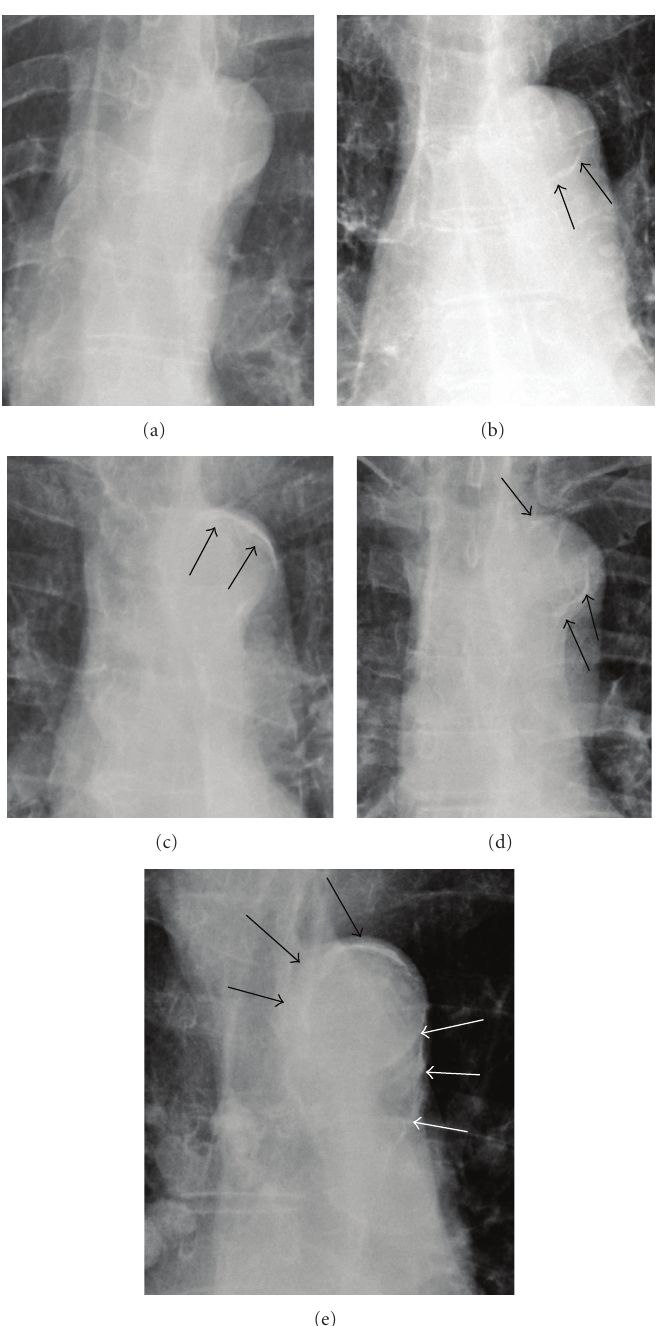
Figure 2: Chest radiographs grading of aortic arch calcification. Five frontal radiographs illustrate the grading scheme of aortic calcification. Arrows show calcifications along the aortic arch. (a) Grade 0: no calcifications visible; (b) grade 1: calcification length between 0-1cm; (c) grade 2: length between > 1-2cm; (d) grade 3: length between > 2-3cm; and (e) grade 4: length greater than 3cm in